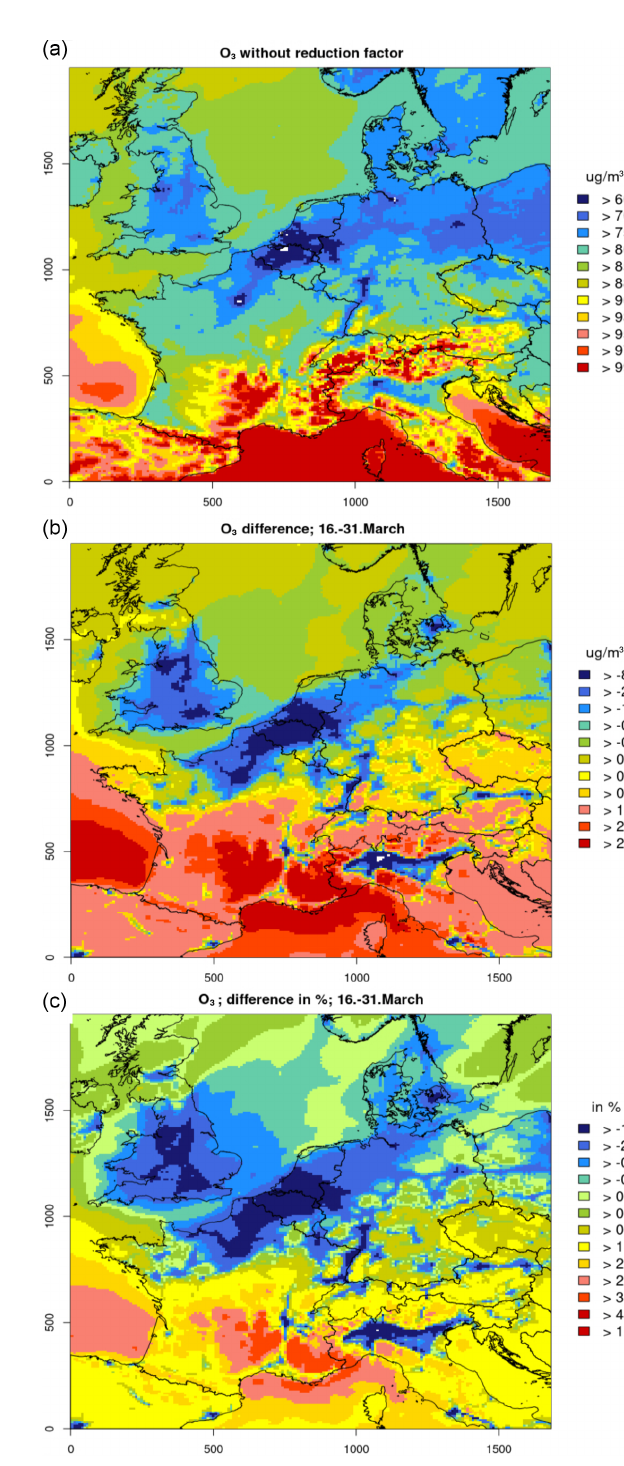
Figure 11. CMAQ results for O 3 concentrations in central Europe between 16 and 31 March 2020. (a) Concentrations without lock- down measures (noCOV run). (b) Absolute concentration reduc- tions due to lockdown measures (noCOV – COV run); positive val- ues denote high reductions. (c) Relative concentration reductions due to lockdown measures (noCOV – COV run); positive values denote reductions, and negative values denote